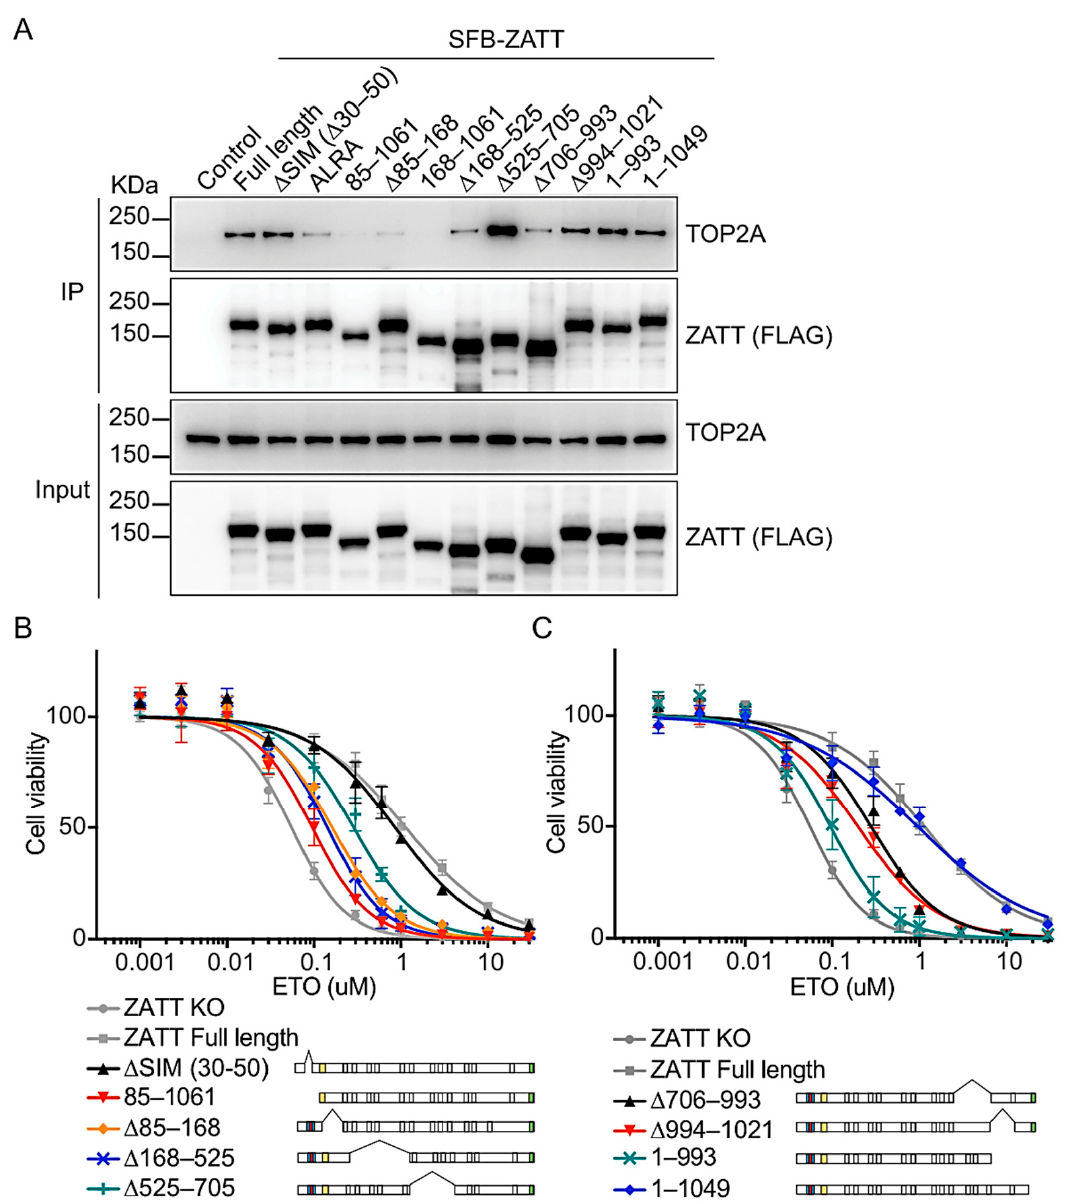
Figure 3. The N-terminal 1–168 region of ZATT is essential for its interaction with TOP2 and both the N- and C-terminal regions of ZATT affect etoposide sensitivity. ( A ) HEK293A cells were transfected with constructs encoding truncated SFB-ZATT or internal deletion mutants and subjected to pull down with streptavidin. Western blotting was conducted with antibodies as indicated. ( B , C ) ZATT KO cells were transfected with indicated constructs and selected with puromycin. Cell survival was measured by a CellTiter-Glo assay after 3 days in the presence of the indicated concentrations of ETO. Each experiment was repeated three independent times done in triplicate each time. Data were represented as mean ± SD. The legends below are schematic depictions of ZATT deletion mutants used in this